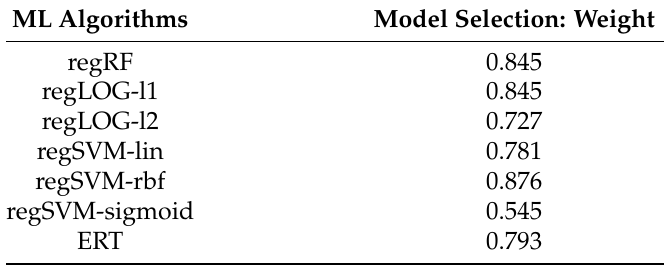
Table 2. The metric of accuracy score of correct predictions is obtained, for various of algorithms employed in this paper.